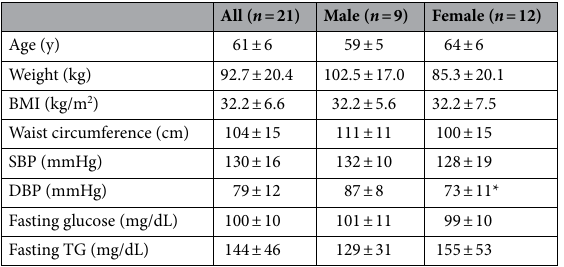
Table 1. Characteristics of subjects at screening visit. Values are reported as mean ± SD. * P < 0.05, women versus men. BMI, body mass index; SBP, systolic blood pressure; DBP, diastolic blood pressure; TG, triglyceride.